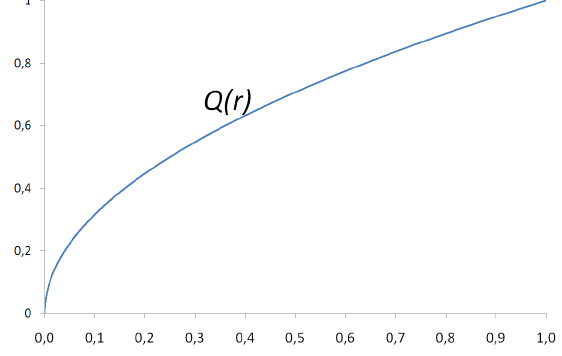
Fig 2. Linguistic quantifier most of : Q ( r ) = r 1 / 2